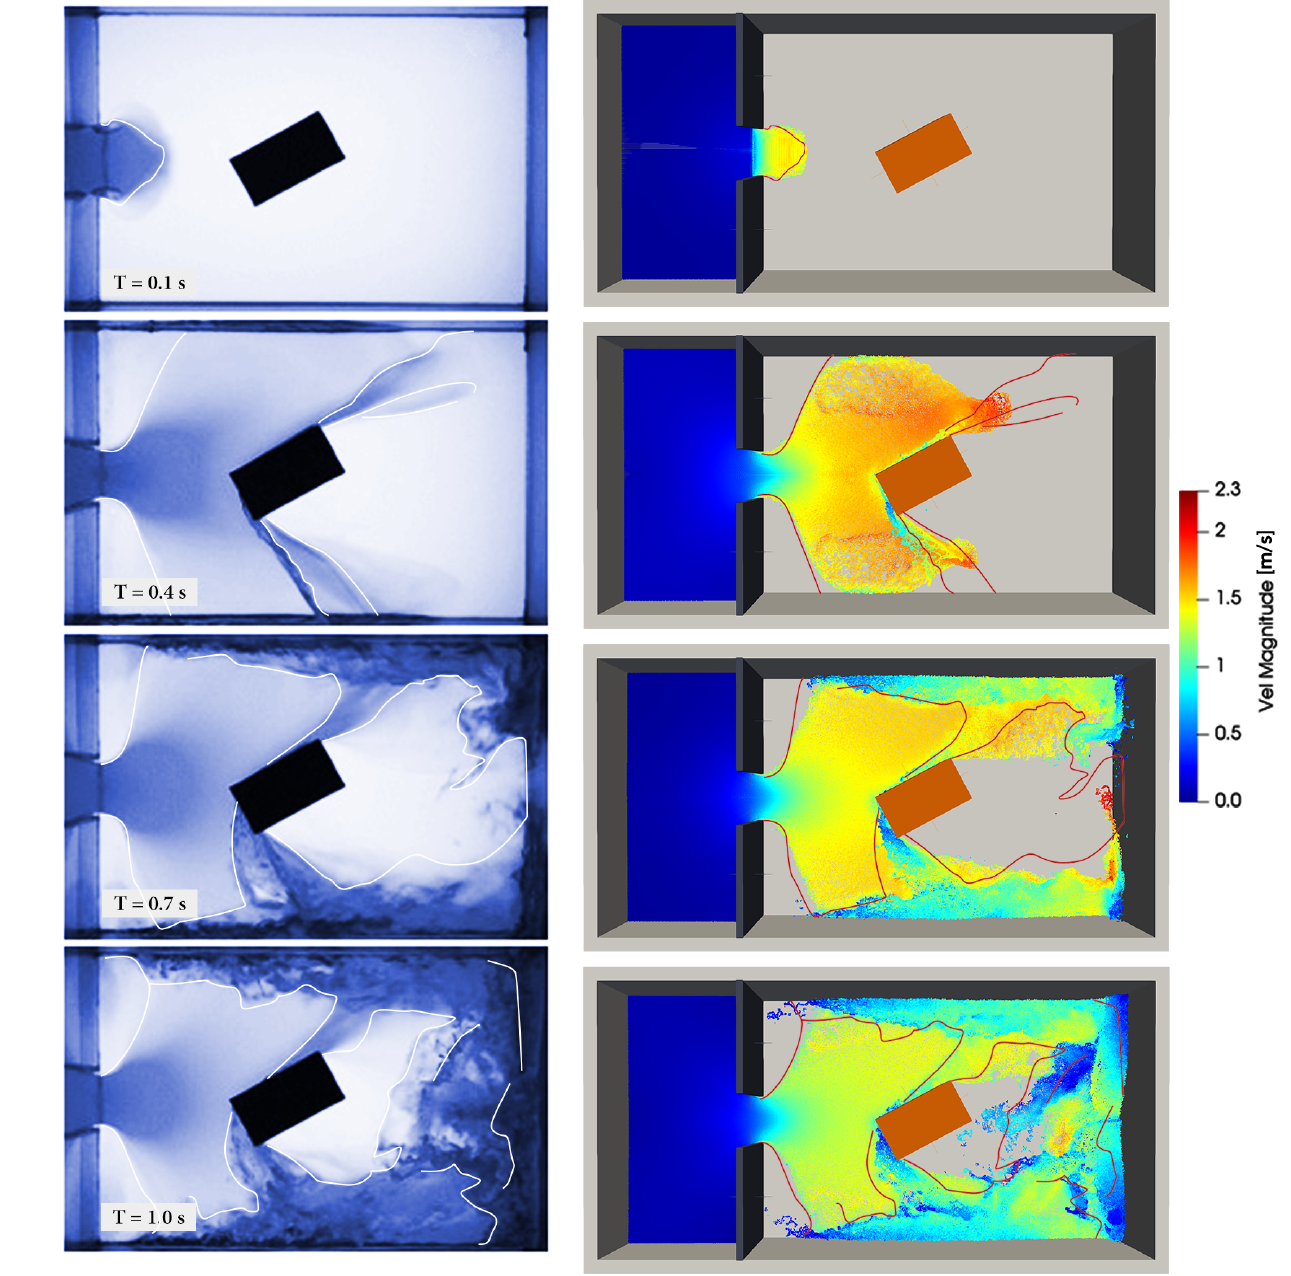
Figure 14. Visual comparison between live experimental frames ( left ) and DualSPHysics simulation with dp = s /4, κ = 1.0, mDBC ( right ). White and red lines highlight the fluid mass shape for easier